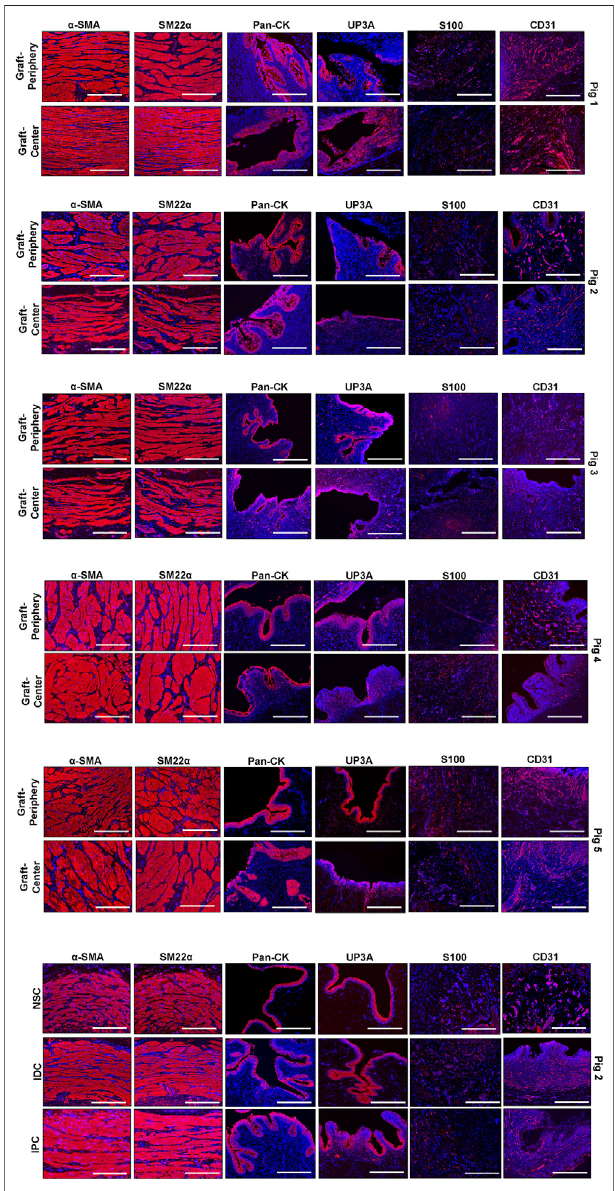
FIGURE 5 | Immunohistochemical evaluations of neconduit maturation and control tissues. Representative photomicrographs of selective protein expression in peripheral and central regions of neotissues at 12 weeks post-op as well as in control groups: NSC, IPC, and IDC. Markers of interest include smooth muscle contractile proteins ( α -SMA, SM22 α ), epithelial proteins (pan-CK, UP3A), as well as vascular (CD31) and innervation (S100) proteins. For all panels, respective marker expression is labeled in red (Alexa Fluor 594 labeling) with DAPI nuclear counterstain displayed in blue. Scale bars (cid:1) 400 µm in each panel. Representative results for Pigs 1 – 5. Control specimens (NSC, IPC, and IDC) were procured from